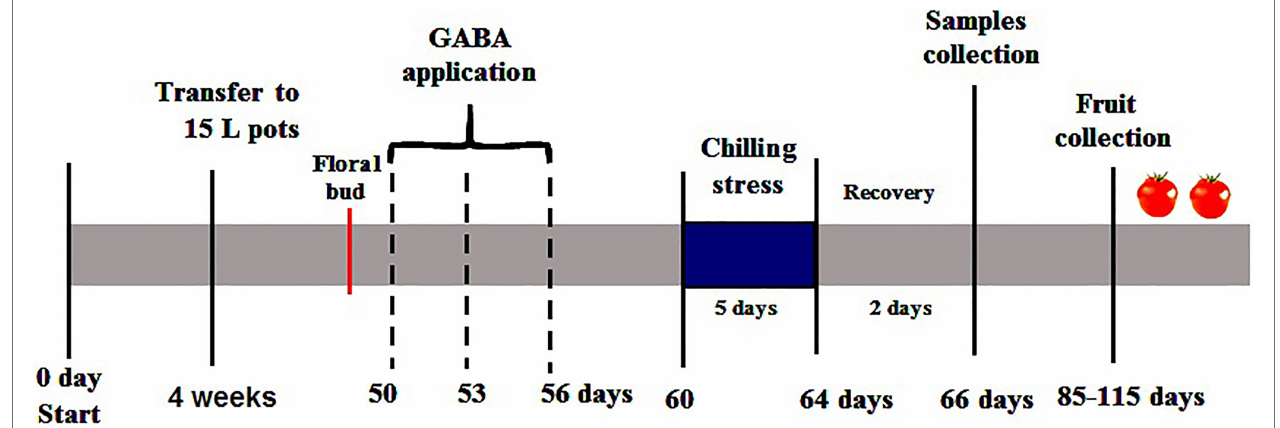
FIGURE 1 | The timeline infographic for the treatments of GABA as a foliar application and the samples’ collection of tomato plants subjected chilling stress in the reproductive